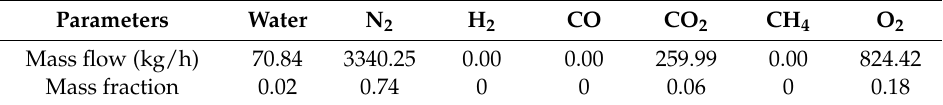
Table 9. Combustor exit flue gas composition.